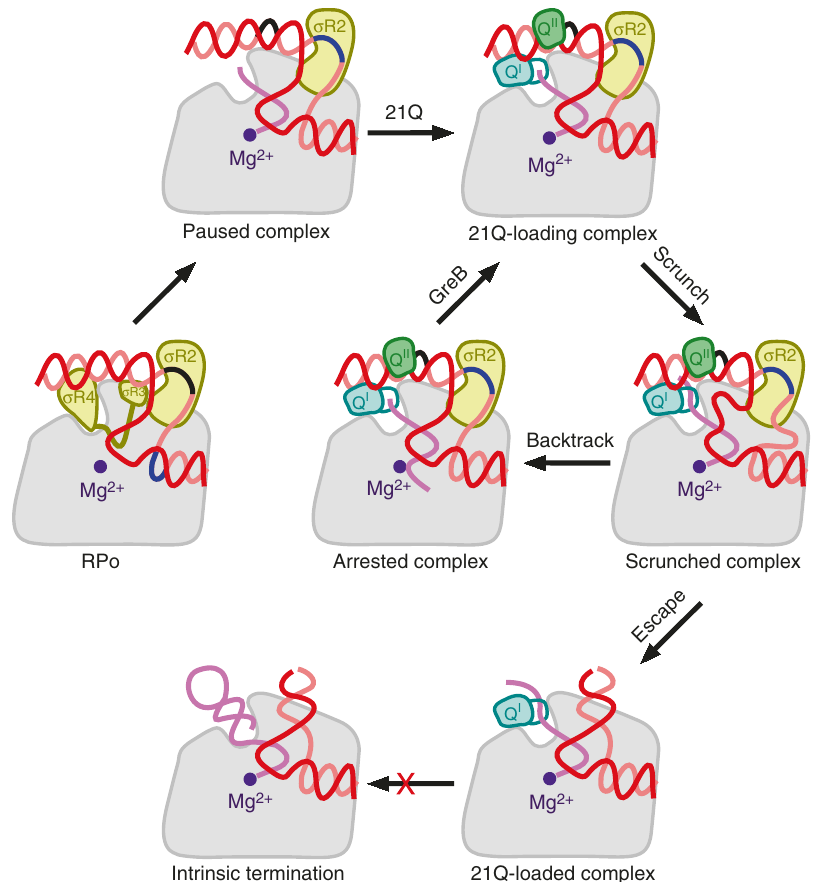
Fig. 6 Pathway for formation of a 21Q-dependent termination-resistant elongation complex. Gray, RNAP; cyan, Q I ; green, Q II ; yellow, σ 70 ; violet, active center Mg 2 + ; salmon, nontemplate strand; red, template strand; pink, RNA; black, the promoter − 10 element; blue, the − 10-like